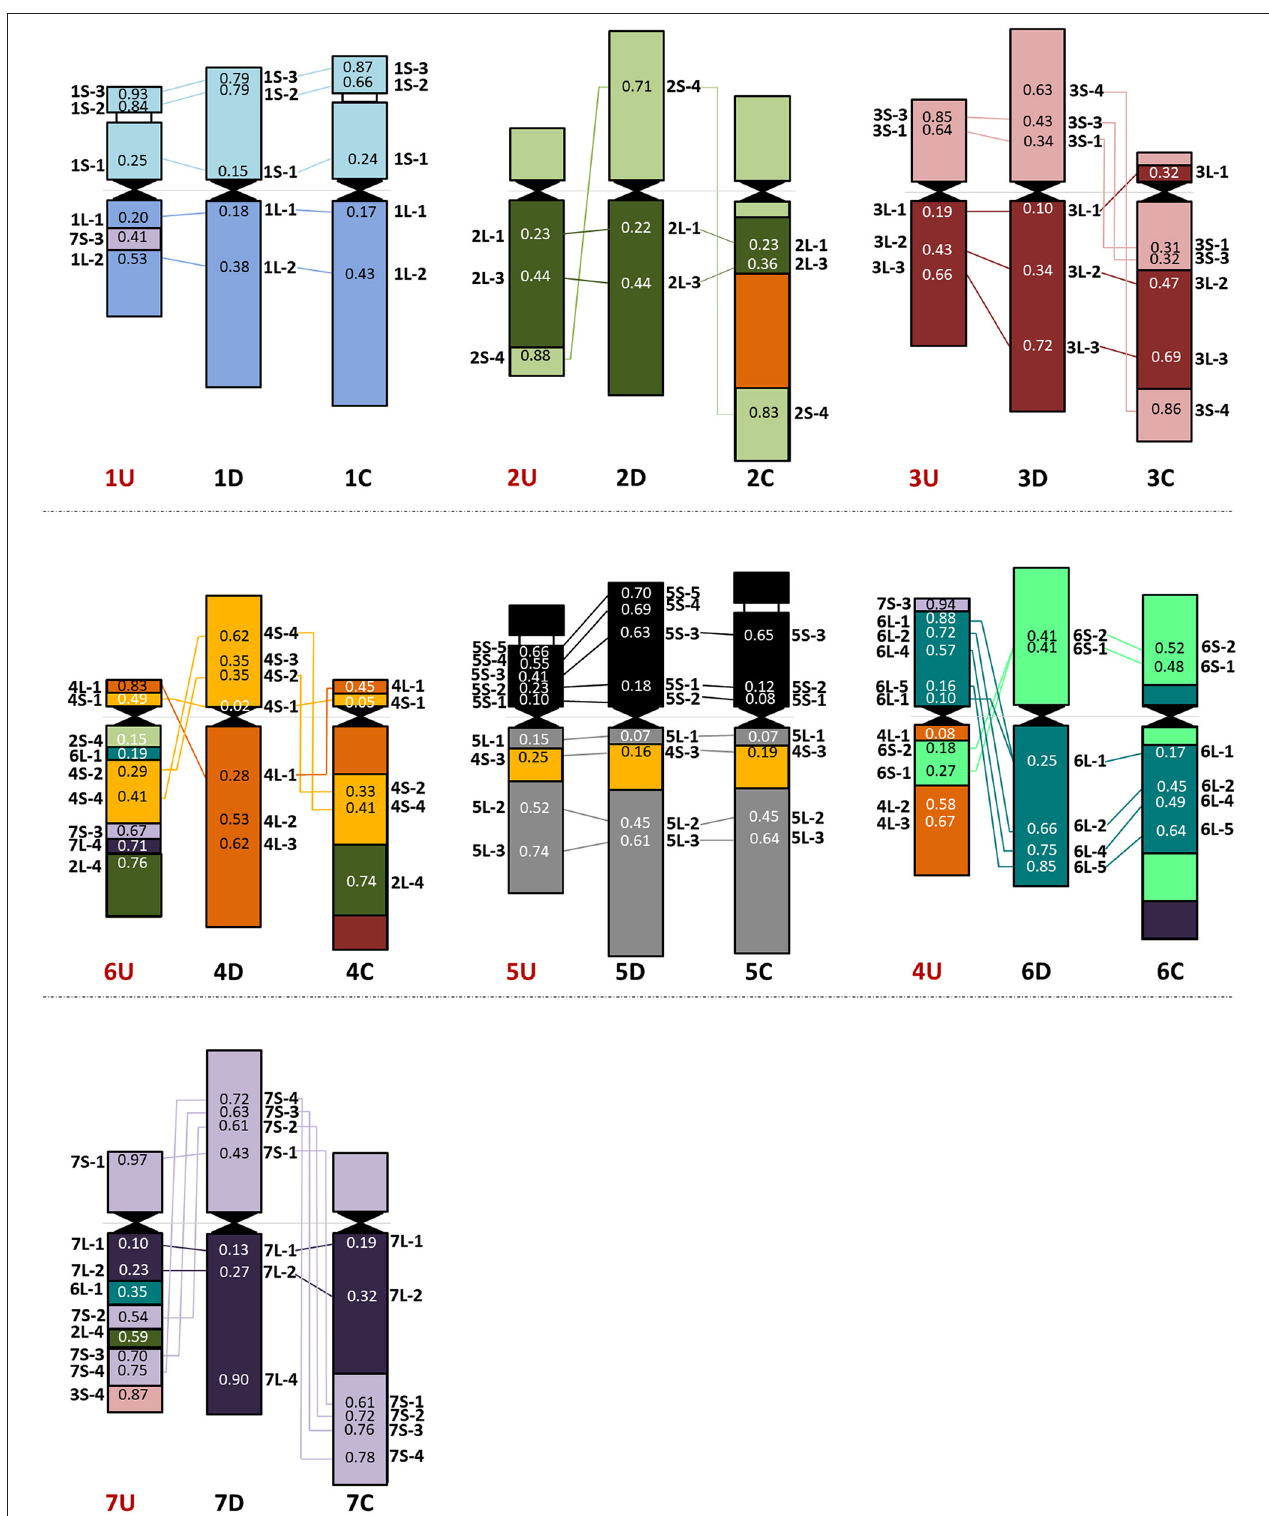
FIGURE 4 | Chromosome organization of the Ae. umbellulata U genome (left) compared with the D (sub)genome of wheat (middle) and the Ae. markgrafii C genome (right) . The average relative positions of cDNAs are shown on the chromosomes.